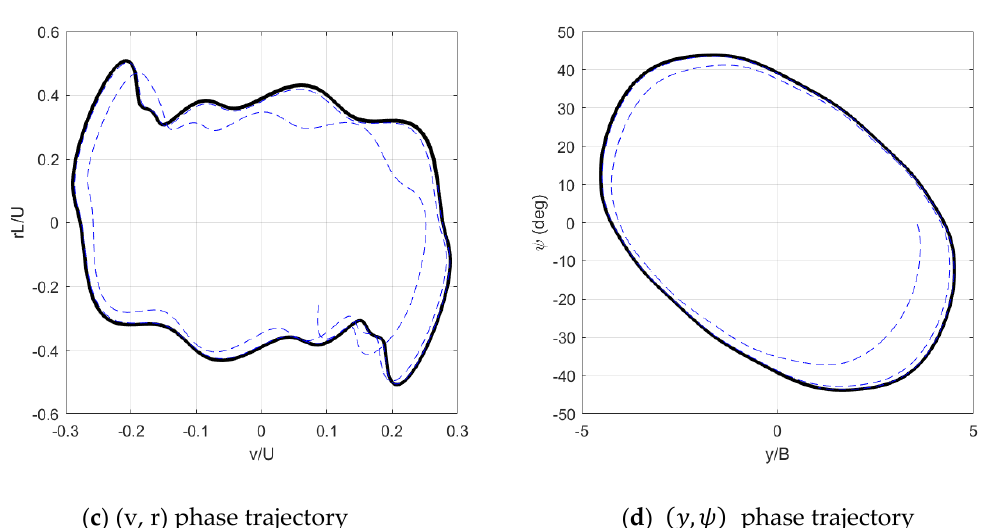
Figure 3. Phase trajectories of the towed vessel (blue dashed: 20–70 s, black solid: 70–500 s).